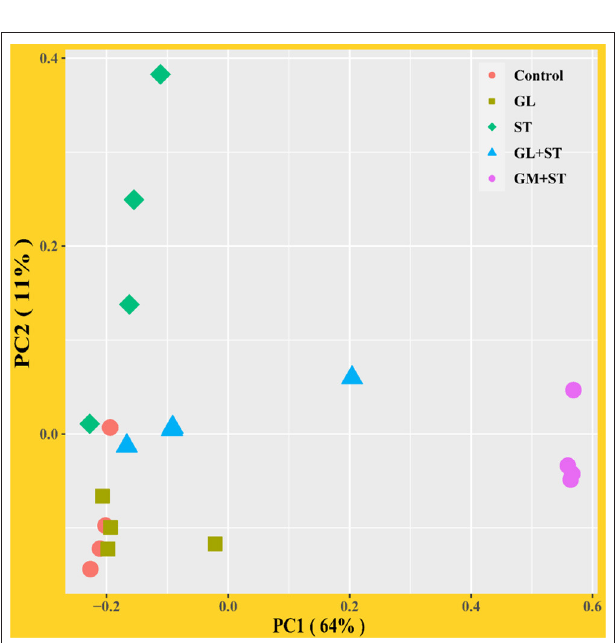
FIGURE 7 | Principal coordinates analysis (PCoA) of microbial communities among groups based on Bray–Curtis distance ( n = 4/group).